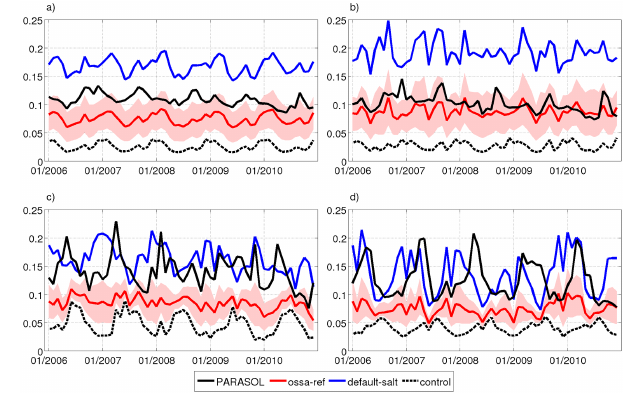
Figure 11. Satellite-retrieved (PARASOL) and modelled monthly mean AOD values (a) over the Southern Ocean, (b) around Amster- dam Island, (c) west of Mace Head and (d) west of Point Reyes (see Fig.